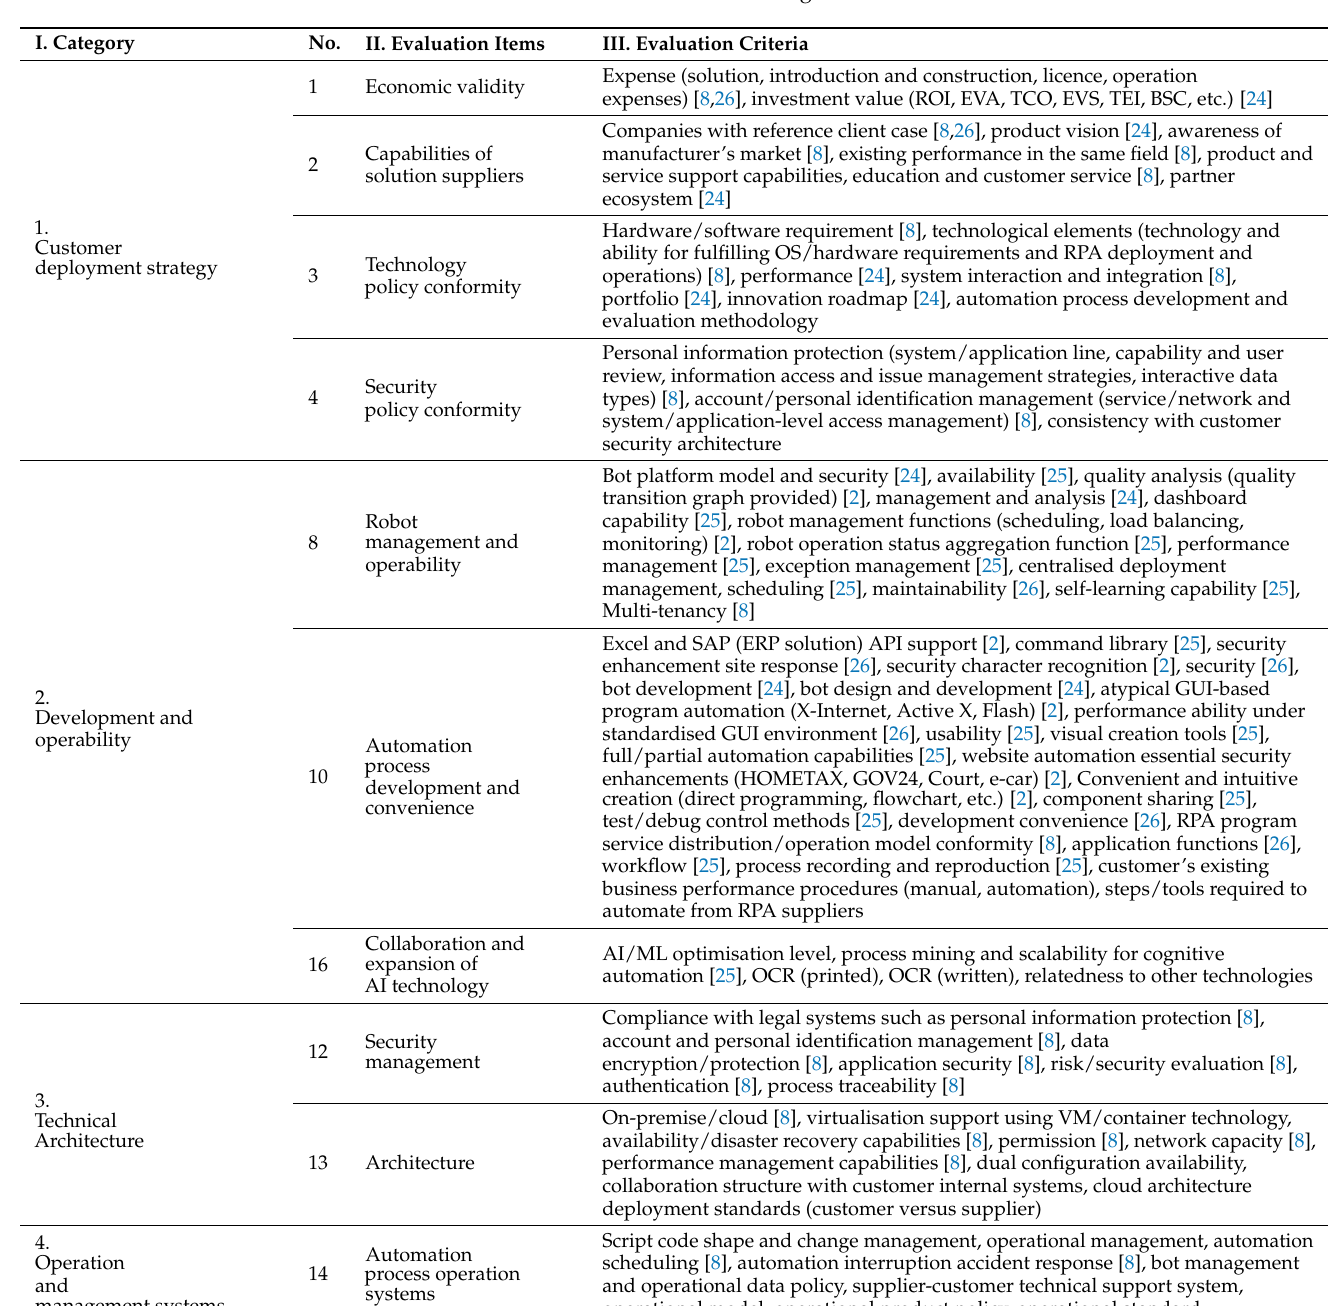
Table 12. Final validated criteria for evaluating RPA